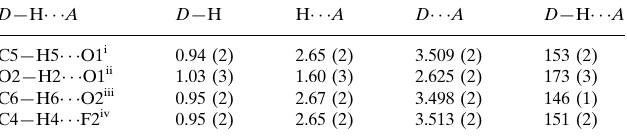
Hydrogen-bond geometry (A˚ , (cid:2)